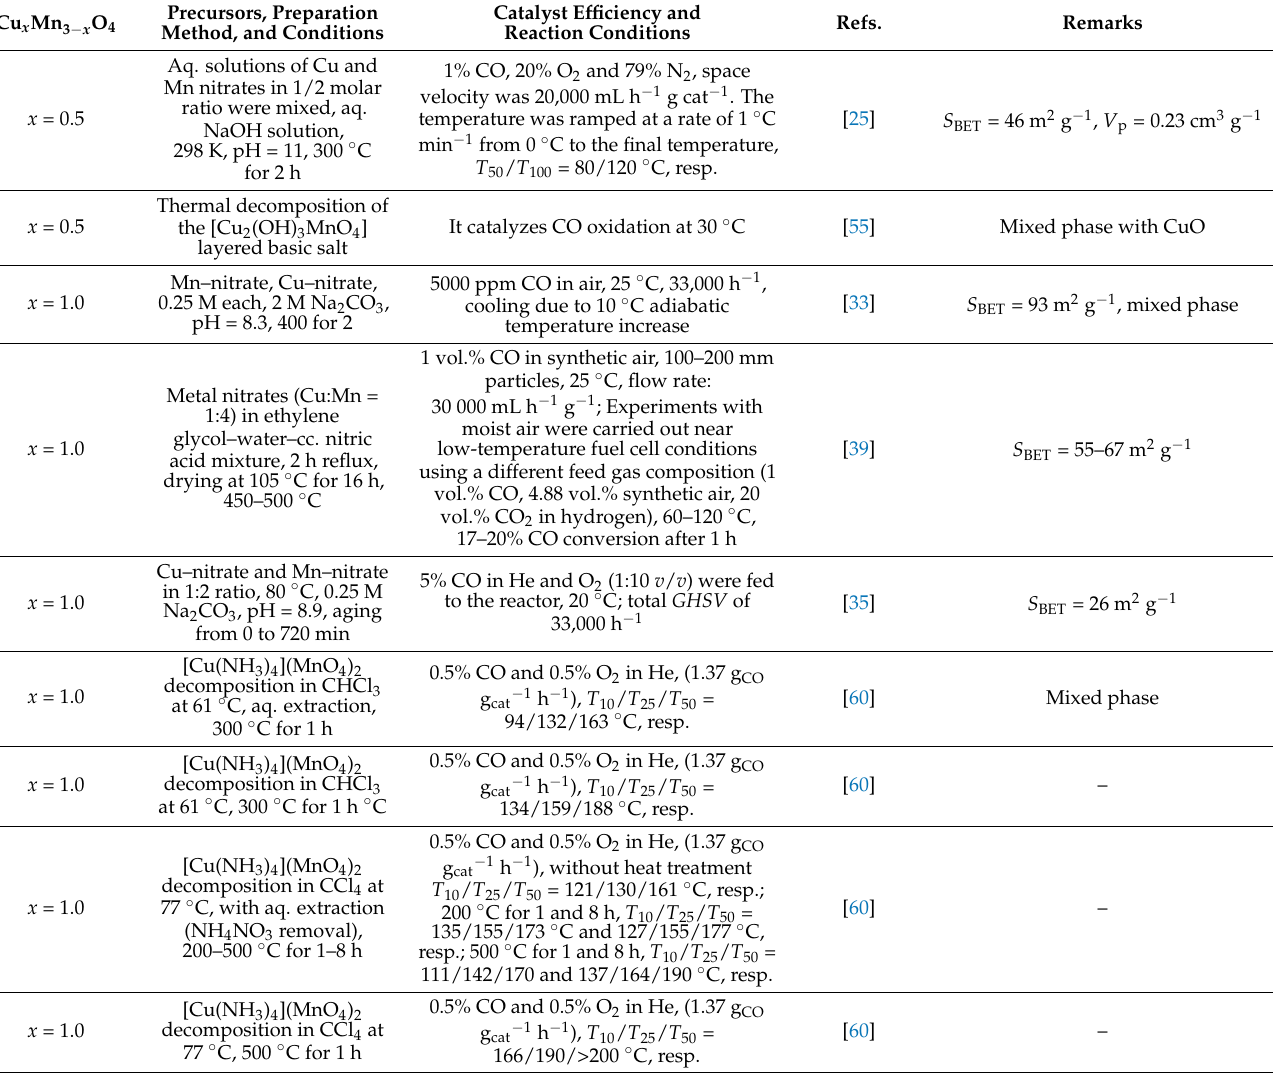
Table 4. Removal of carbon monoxide from the air in the presence of Cu x Mn 3 − x O 4